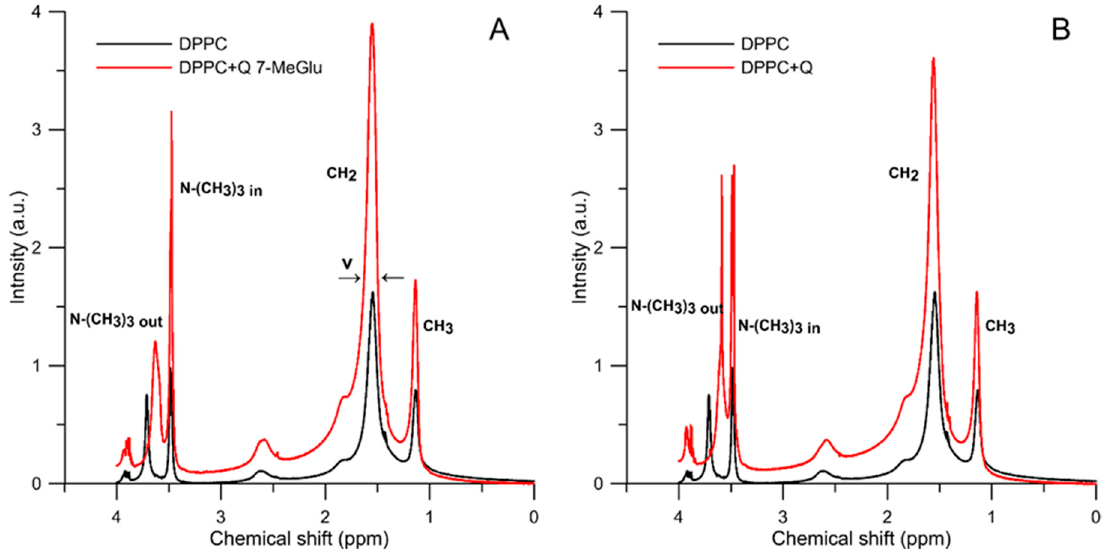
Figure 1. 1 H-NMR spectra of liposomes (at 325 K) formed from pure DPPC (36 mM) and DPPC with ( A ) quercetin 7- O - β - D -(4 ″ - O -methyl)glucopyranoside (Q 7-MeGlu) and ( B ) quercetin (Q) at concentration 0.24 mM. PrCl 3 (4 mM) was added to the samples before measurement.